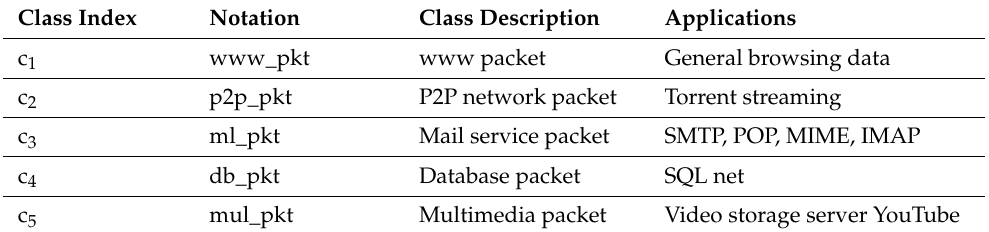
Table 4. Classes of network